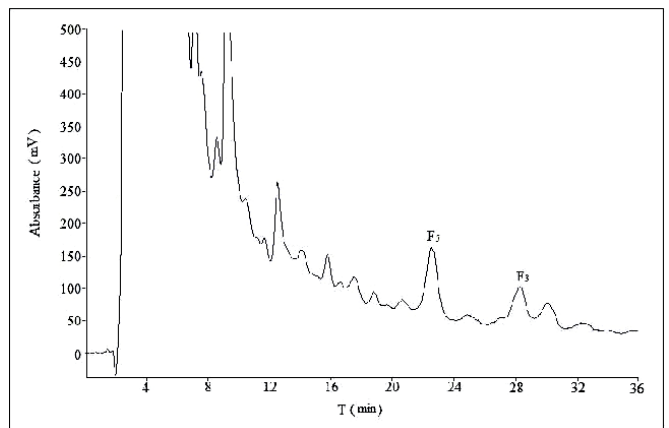
Figure 8. The semi-preparative chromatogram of CEFBPG with the mobile phase of acetonitrile:water 32:68 → 28:72 (15 min) at room temperature and a flow rate of 10 mL/min.